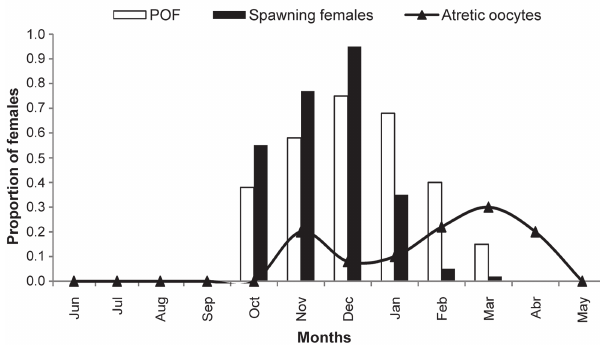
Fig. 3. Monthly proportions of Pagrus pagrus females with hydrated oocytes, post-ovulatory follicles (POF) and atretic oocytes.